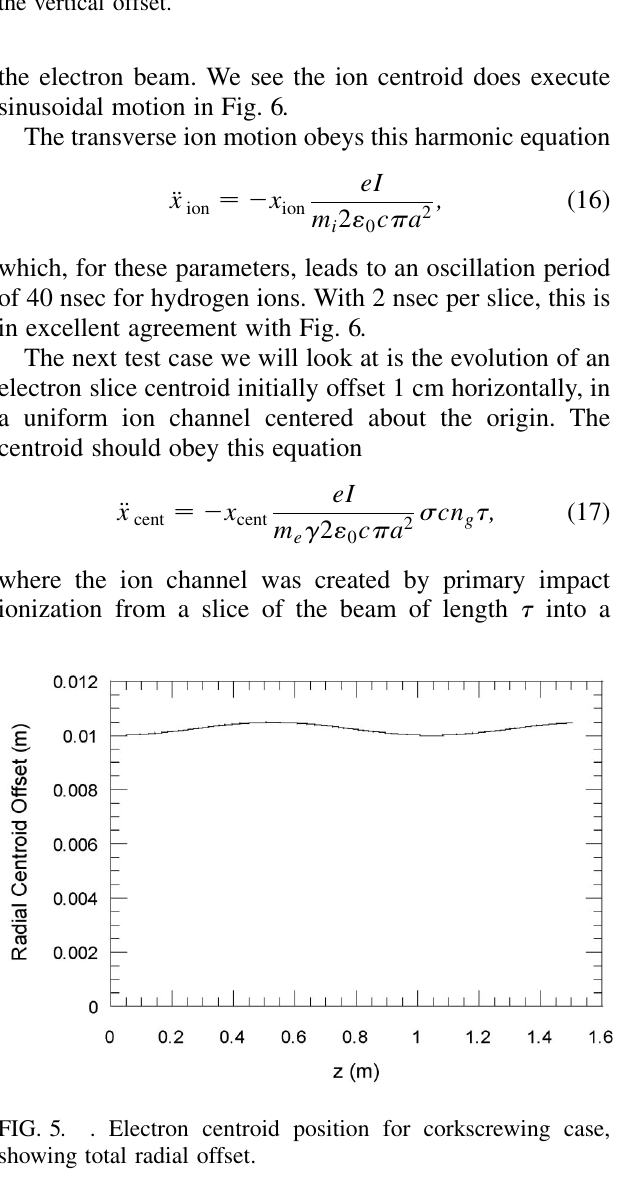
FIG. 4. (Color) Electron-beam centroid position for corkscrew- ing case. The red line is the horizontal offset and the blue line is the vertical offset.